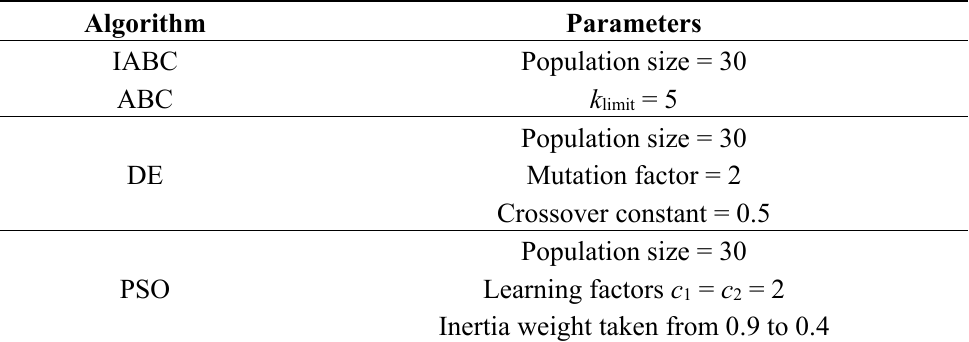
Figure 5. Convergence curve of difference optimization algorithms: ( a ) Sphere function; ( b ) Griewank function; ( c ) Ragstrigin function; ( d ) Rosenbrock function; ( e ) Ackley function; ( f ) Schaffer function. Table 2. Control parameters of optimization